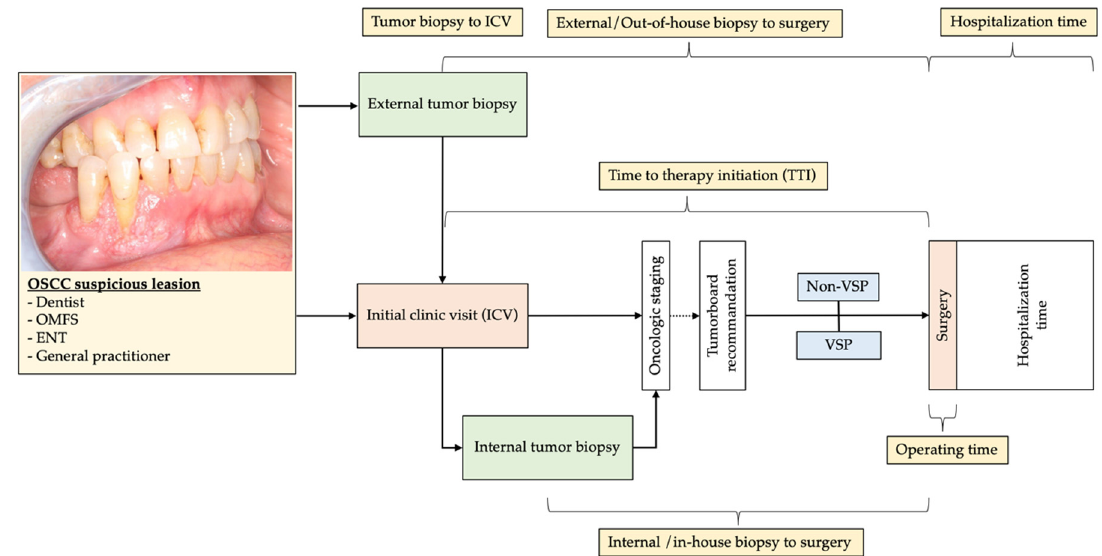
Figure 1. The typical workflow of the first diagnosis of OSCC and referral to oncologic reconstructive OMFS-department and initial clinic visit (ICV). Time intervals of study interest are marked in yellow boxes and correlated to the method of immediate jaw reconstruction.